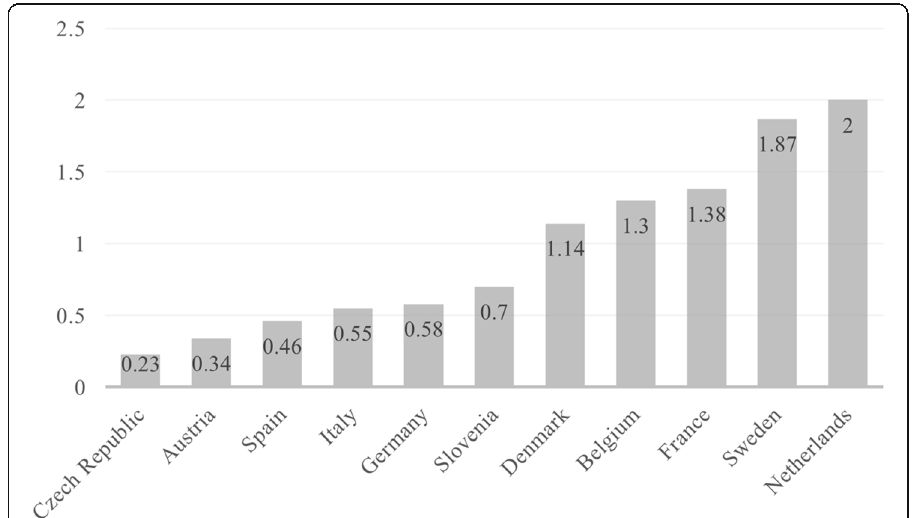
Fig. 1 Public expenditure on LTC in institutions as % of GDP, 2010. Data for Switzerland not available. Source: Lipszyc, Sail, & Xavier